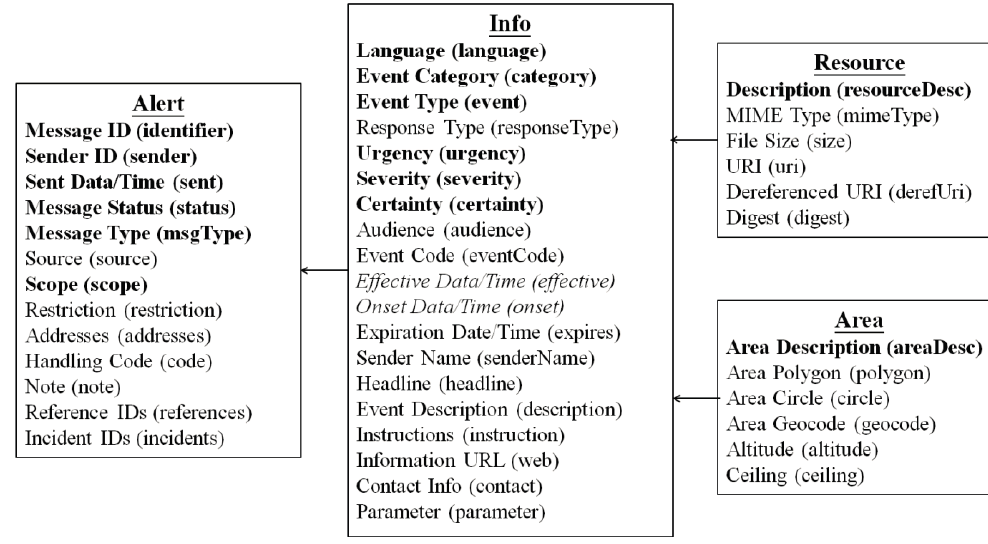
Figure 5. Common alerting protocol